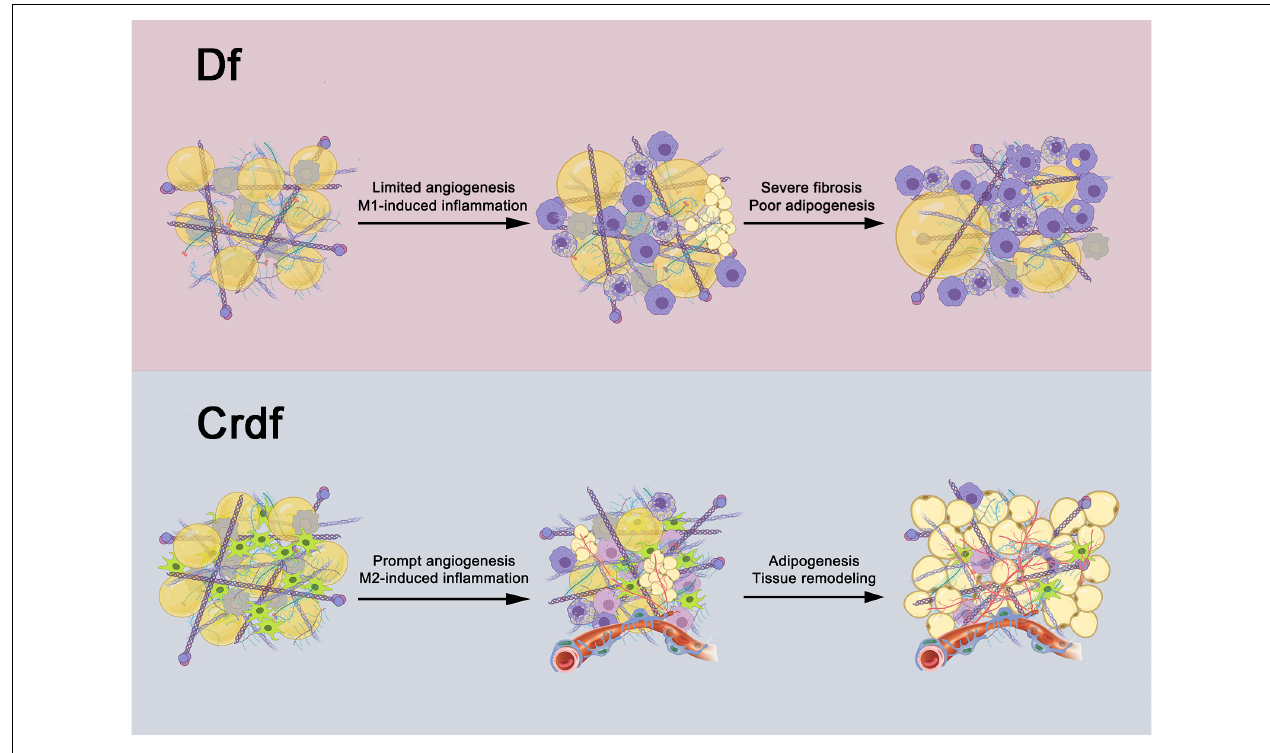
FIGURE 6 | Potential role of ASCs in fat regeneration. After all adipocytes and SVF cells within the graft are removed, adipogenesis can be induced by the transplanted adipose ECM and the microenvironment in Df. However, the sustained presence of M1 inflammation and slow angiogenesis leads to poor adipogenesis and severe fibrosis. Supplementation with ASCs in Df can drive M1 macrophages into M2 polarization as well as develop into endothelial cells of vessels, which promote inflammation resolution and enhance angiogenesis, collectively contribute to mature adipogenesis.